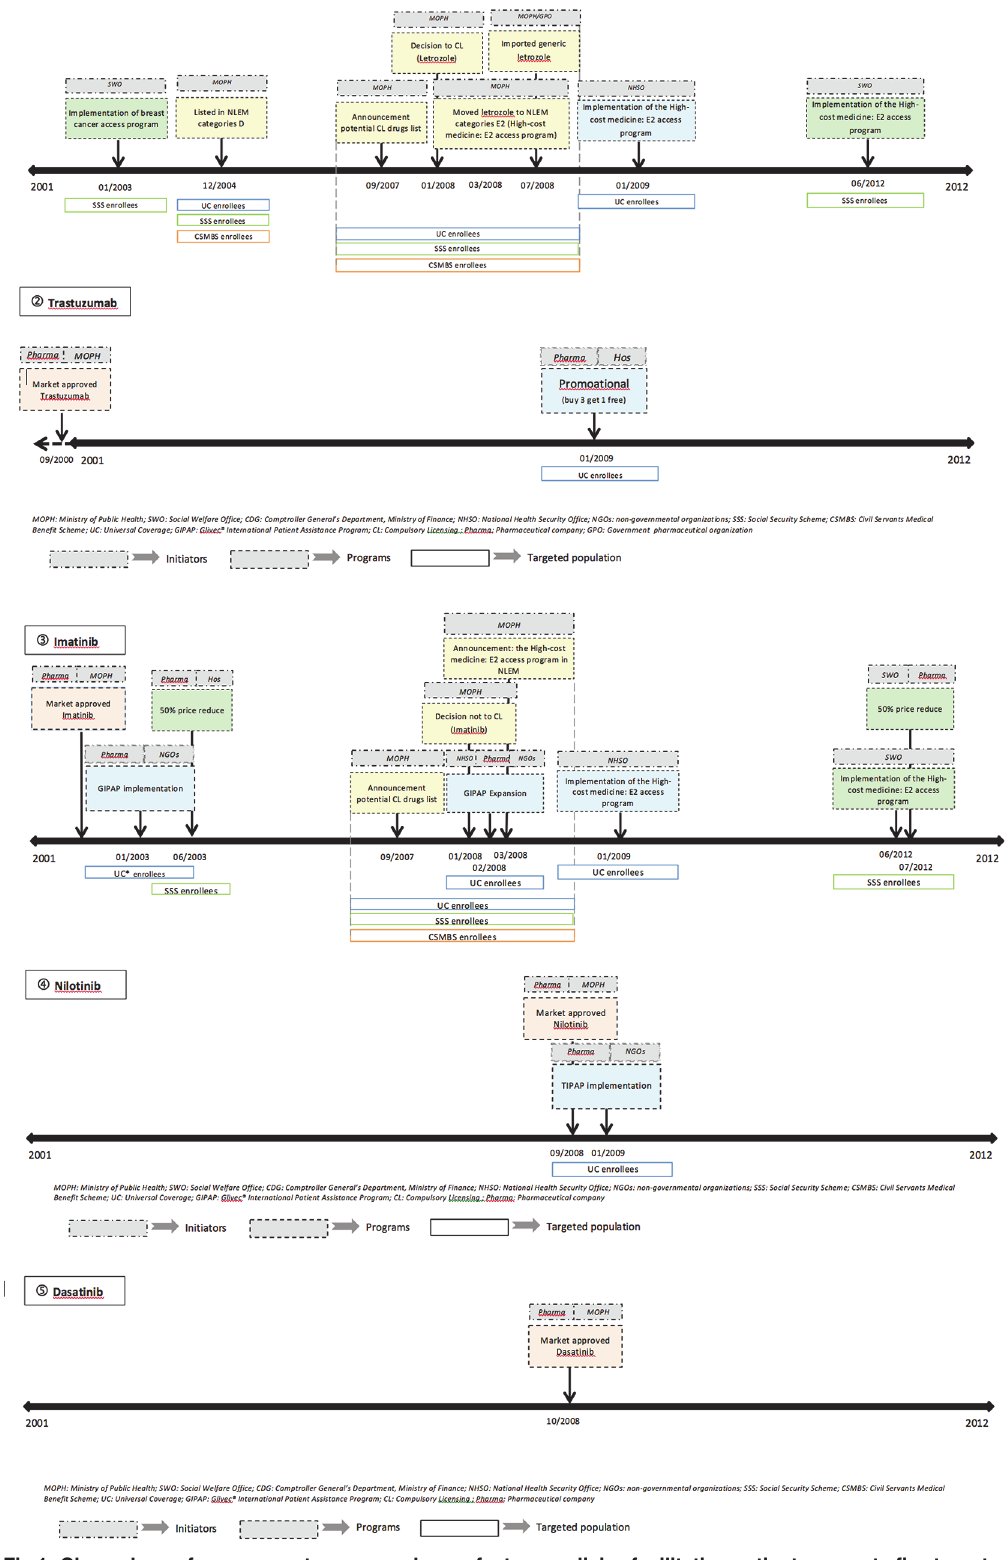
Fig 1. Chronology of government, payer, and manufacturer policies facilitating patient access to five targeted cancer therapies.